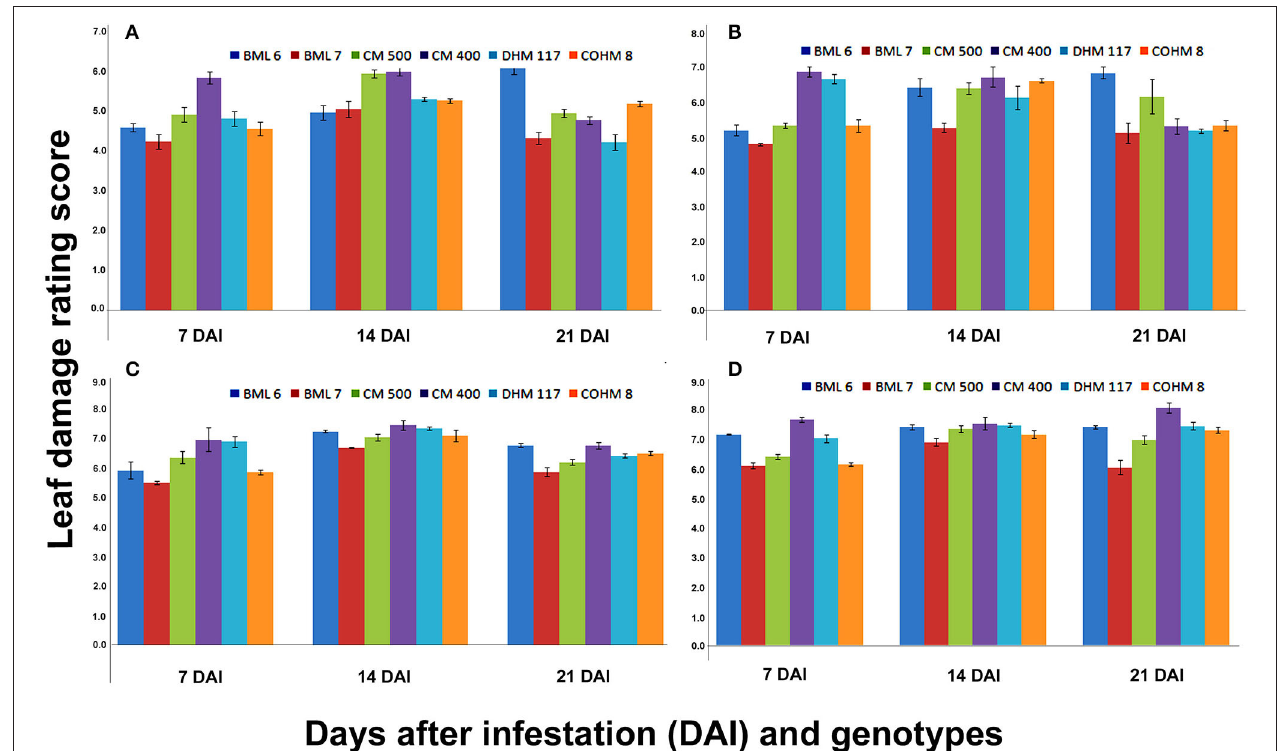
FIGURE 2 | Leaf damage rating (LDR) scores at V 5 phenological stage of maize under artificial infestation in net house conditions at 7,14 and 21